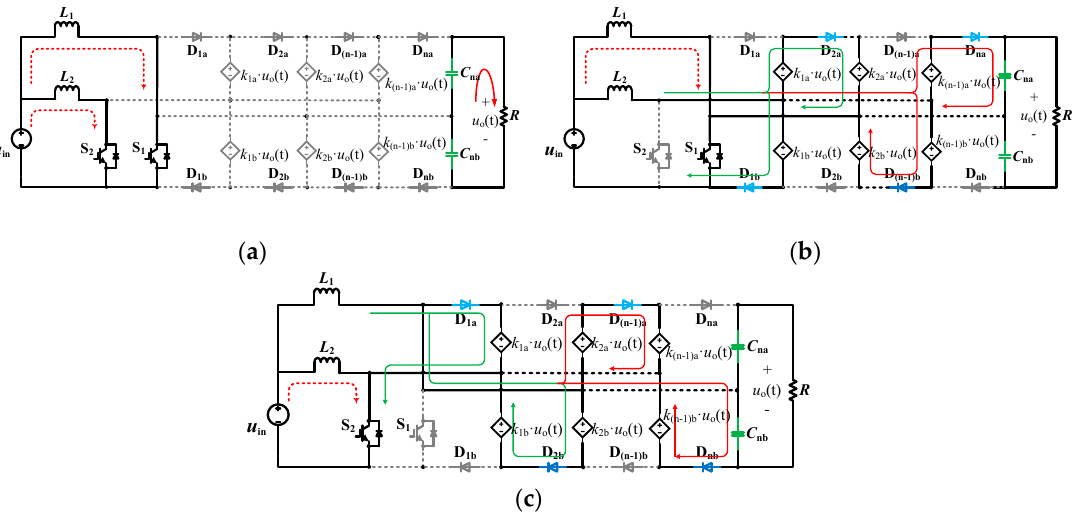
Figure 4. Three working state equivalent circuits of the VM converter: ( a ) S 1 , S 2 are both on; ( b ) S 1 is on and S 2 is off; ( c ) S 2 is on and S 1 is off.